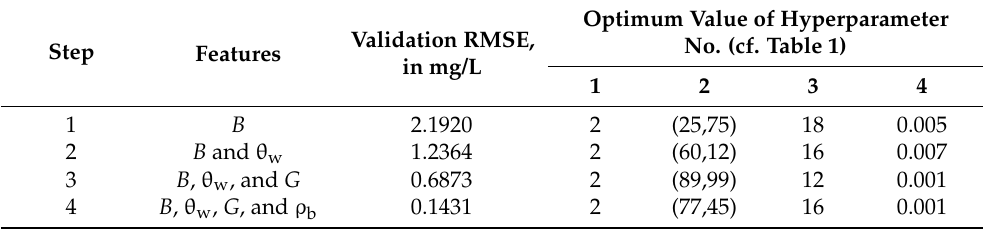
Table 2. Results of feature selection by SFS with the validation RMSE of the LSTM output as criterion to be